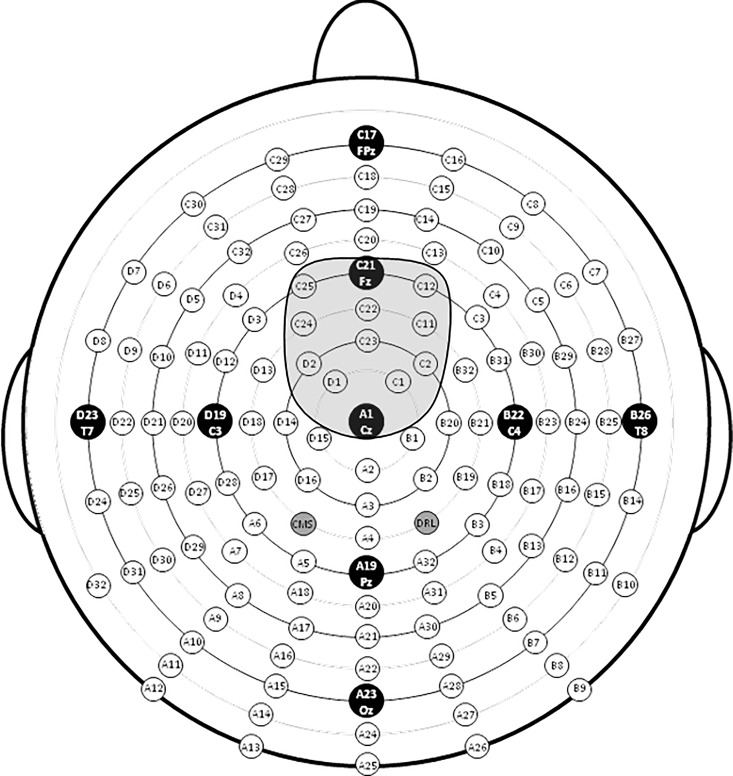
Illustration of the frontocentral cluster of electrode sites used for ERP measurements of the N1 component.